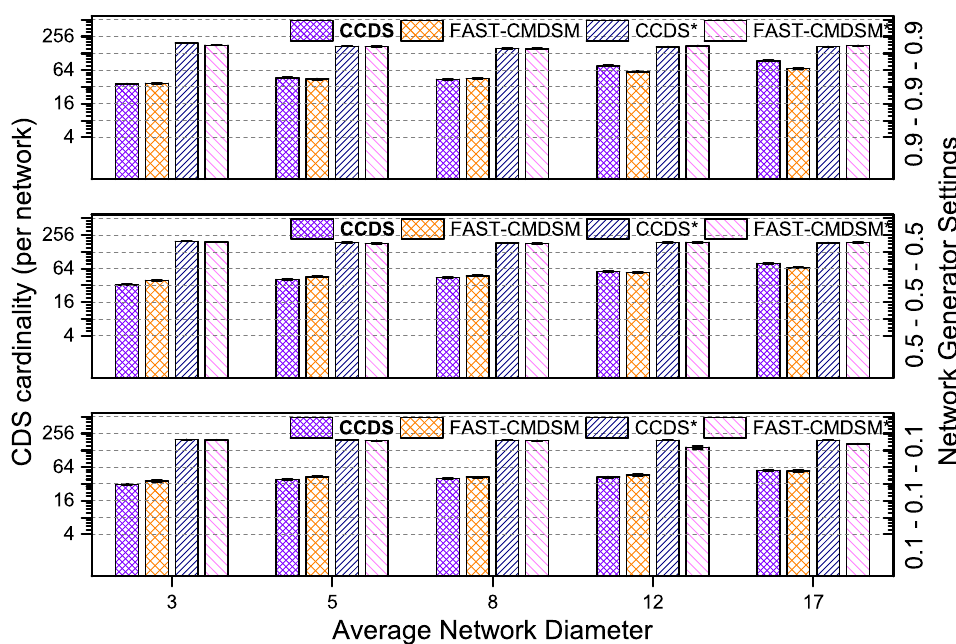
Figure 9. Impact of network diameter (CDS size aggregated over all